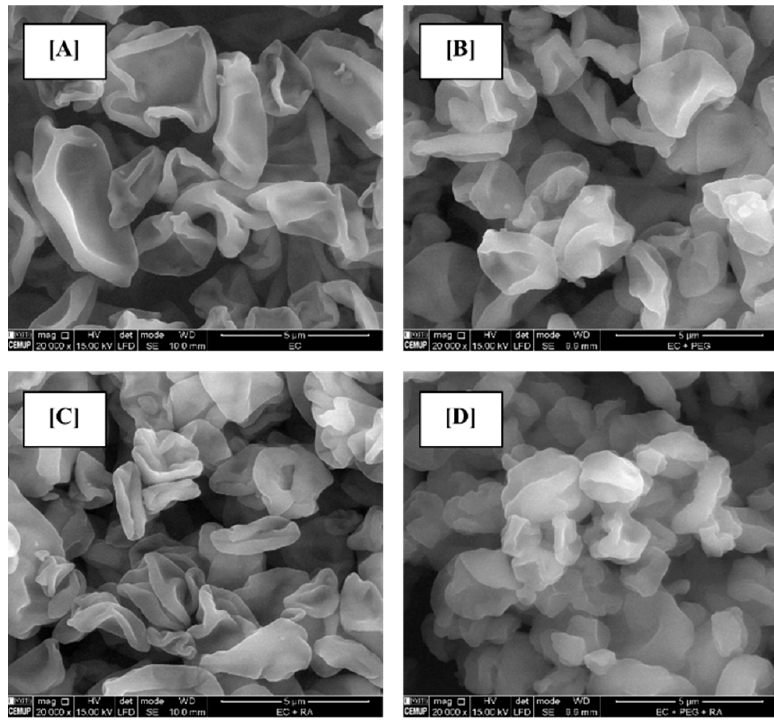
Figure 1. Surface morphology of MpPE ( A , B ) and MpPRA ( C , D ) microparticles composed by EC ( A , C ) and EC + PEG blend ( B , D ). Magnification = 20,000 times, beam intensity (HV) 15.00 kV, distance between the sample and the lens (WD) around 10